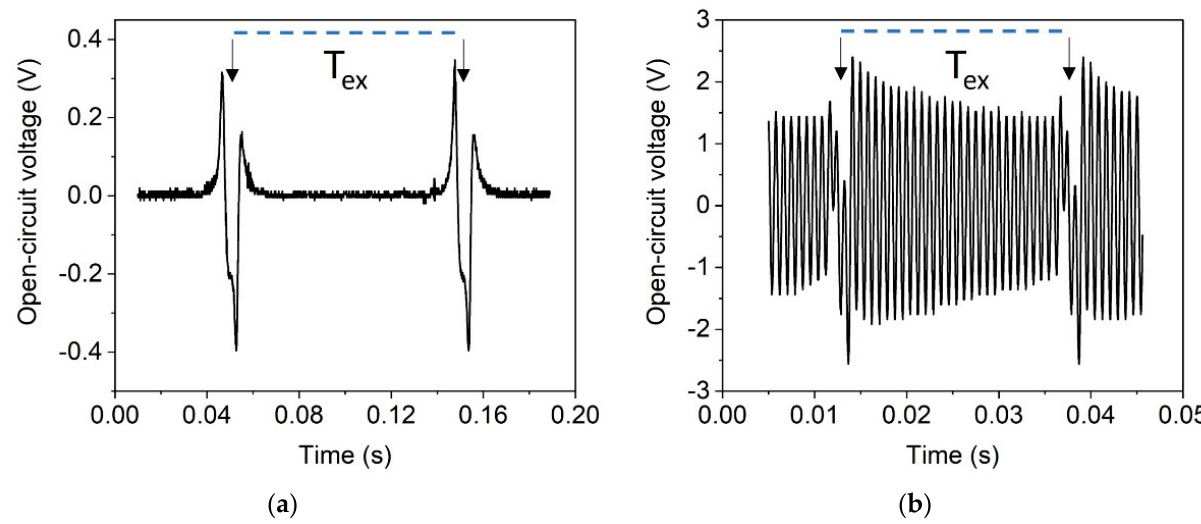
Figure 20. Time-dependent open-circuit voltage signal for a harvester of design 2 excited by a single magnet in rotary motion (see Figure 8b). Single excitation events are highlighted with arrows. The period length T ex of the external excitement magnet is highlighted with a dotted line. ( a ) Harvester response at low excitation magnet velocity (v r = 1.55 m/s); ( b ) magnetic plucking at v r = 6.27 m/s, corresponding to an excitation frequency of 39.9 Hz.